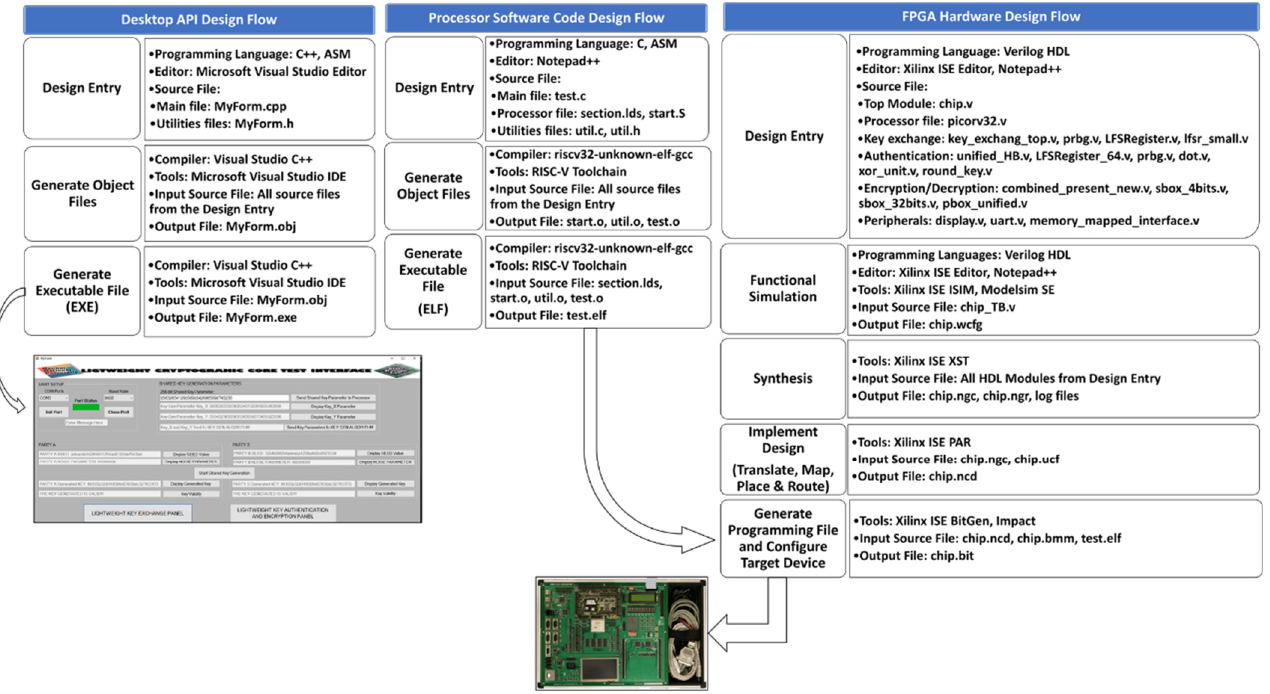
Figure 20. FPGA board test design flow.